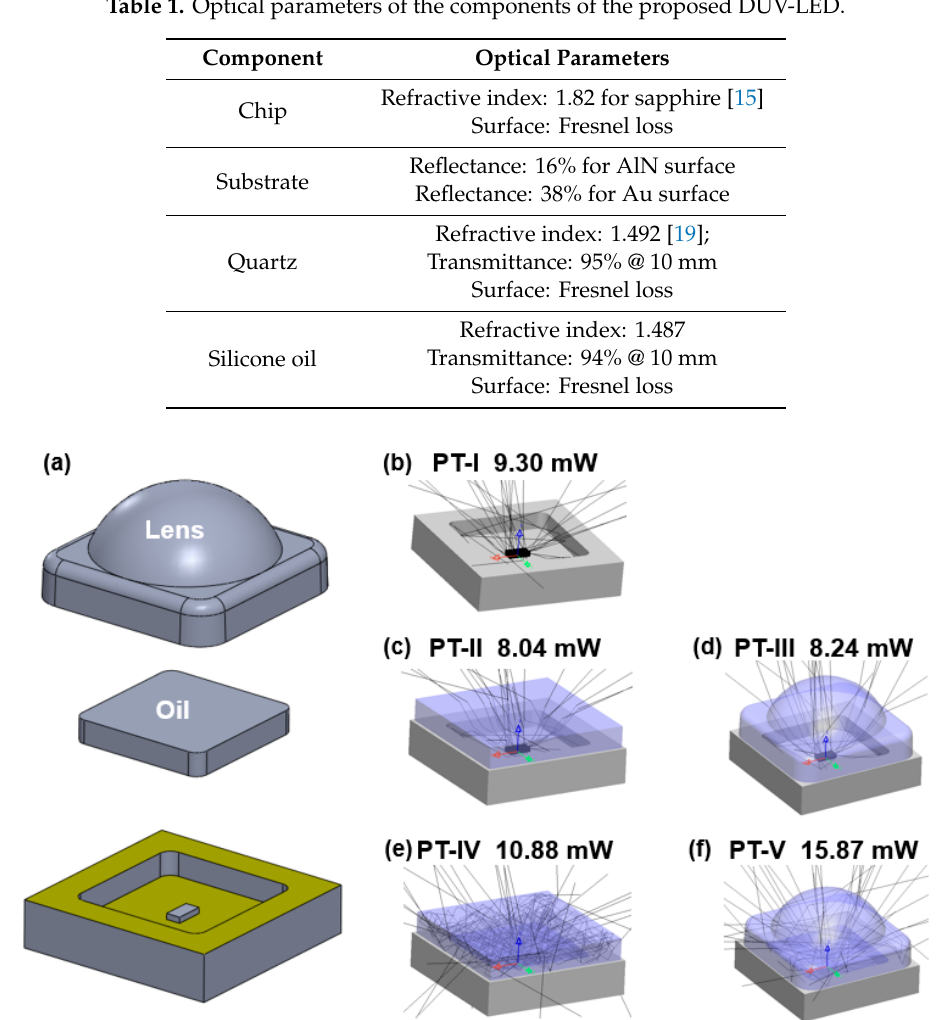
Figure 3. ( a ) 3D model for the simulation, and the simulation results for the output power for ( b ) PT-I, ( c ) PT-II, ( d ) PT-III, ( e ) PT-IV, and ( f ) PT-V DUV-LEDs. Table 1. Optical parameters of the components of the proposed DUV-LED.